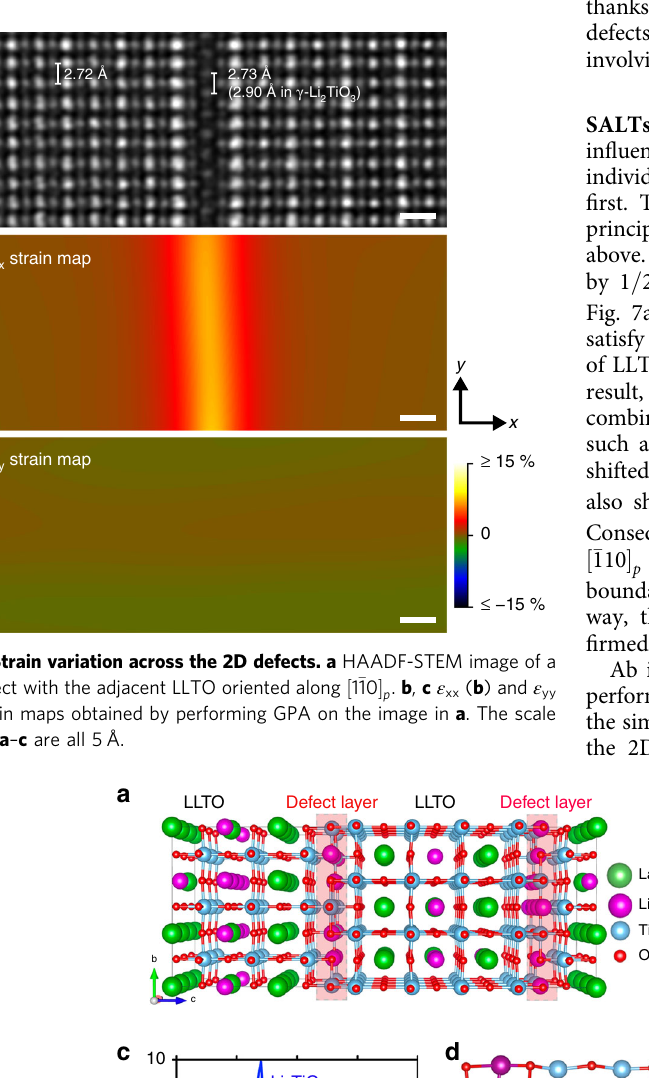
Fig. 5 First principles atomistic modeling of the 2D defects. a Atomistic model used for calculations. b MSD of Li ions in bulk LLTO versus that within (and also parallel with) the 2D defect layer from AIMD simulations at 2000 K. c Radial distribution functions g(r) of Li-O bonds in the 2D defect layer, β - Li 2 TiO 3 , and bulk LLTO. The 2D defect layer has shorter Li-O bond length than bulk LLTO and β -Li 2 TiO 3 . d Li-ion migration pathways selected for NEB calculations in the 2D defect layer. e Migration energy pro fi les of selected Li-ion pathways in the 2D defect layer (red data, pathways indicated in d ) and of similar pathways within the (202) plane of β -Li 2 TiO 3 (blue data, pathways indicated in Supplementary Fig.